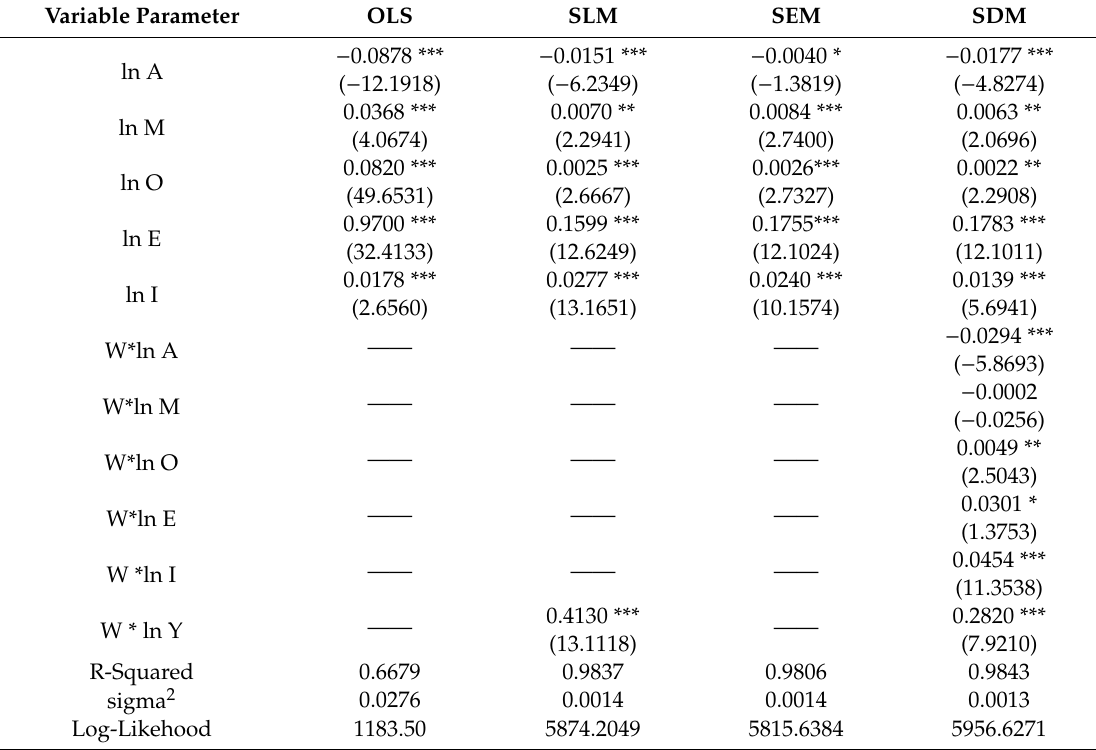
Table 3. Spatial regression model of driving forces for urbanization coordination level. Variable